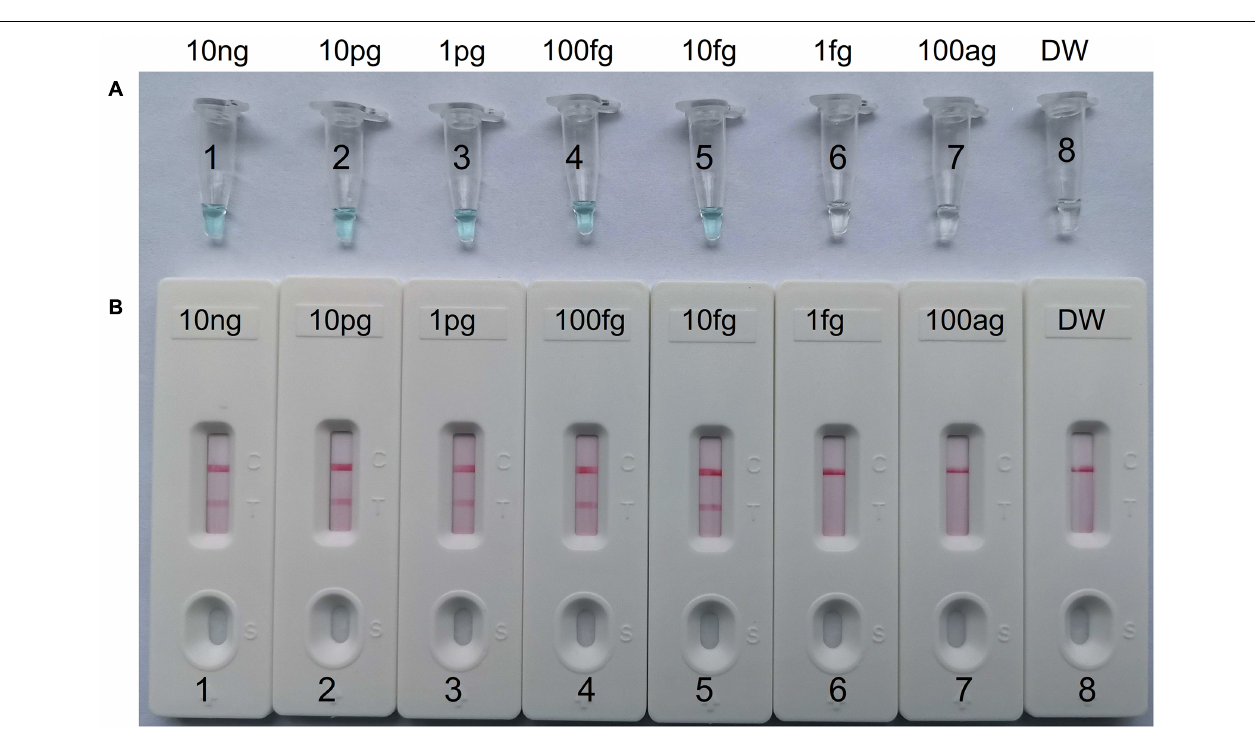
FIGURE 4 | The detection limit of C. tropicalis -MCDA-LFB assays. Two measurement techniques, including (A) a colorimetric indicator (MG) and (B) lateral flow biosensor. A series of dilutions (10 ng, 10 pg, 1 pg, 100 fg, 10 fg, 1 fg, and 100 ag) of C. tropicalis ATCC13803 DNA and a blank control (DW) were operated according to standard MCDA